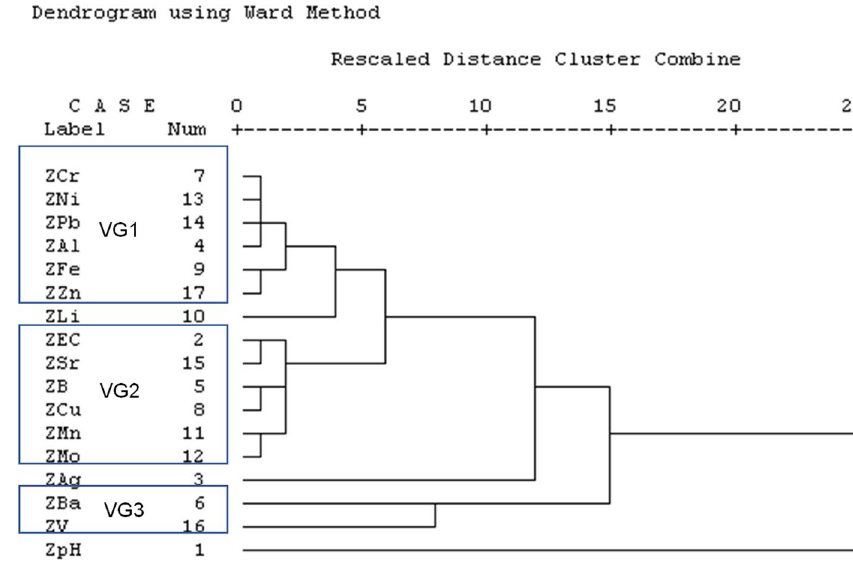
Fig. 5 Dendrogram resulted from R-mode (variables) HCA